Question: What kind of plot is shown here?
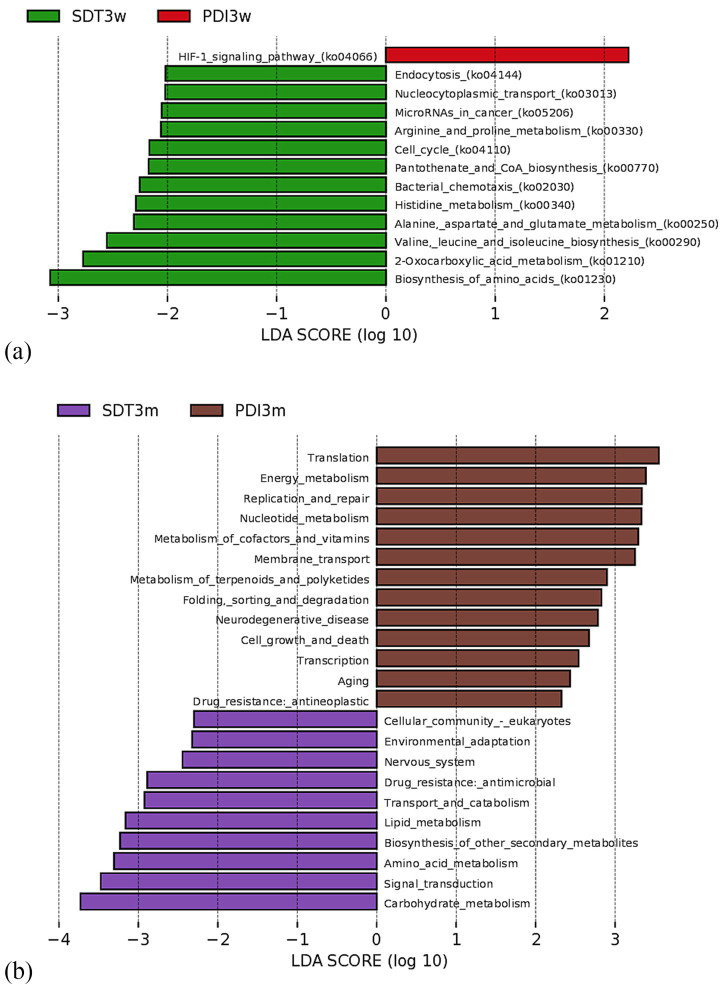
Answer: bar